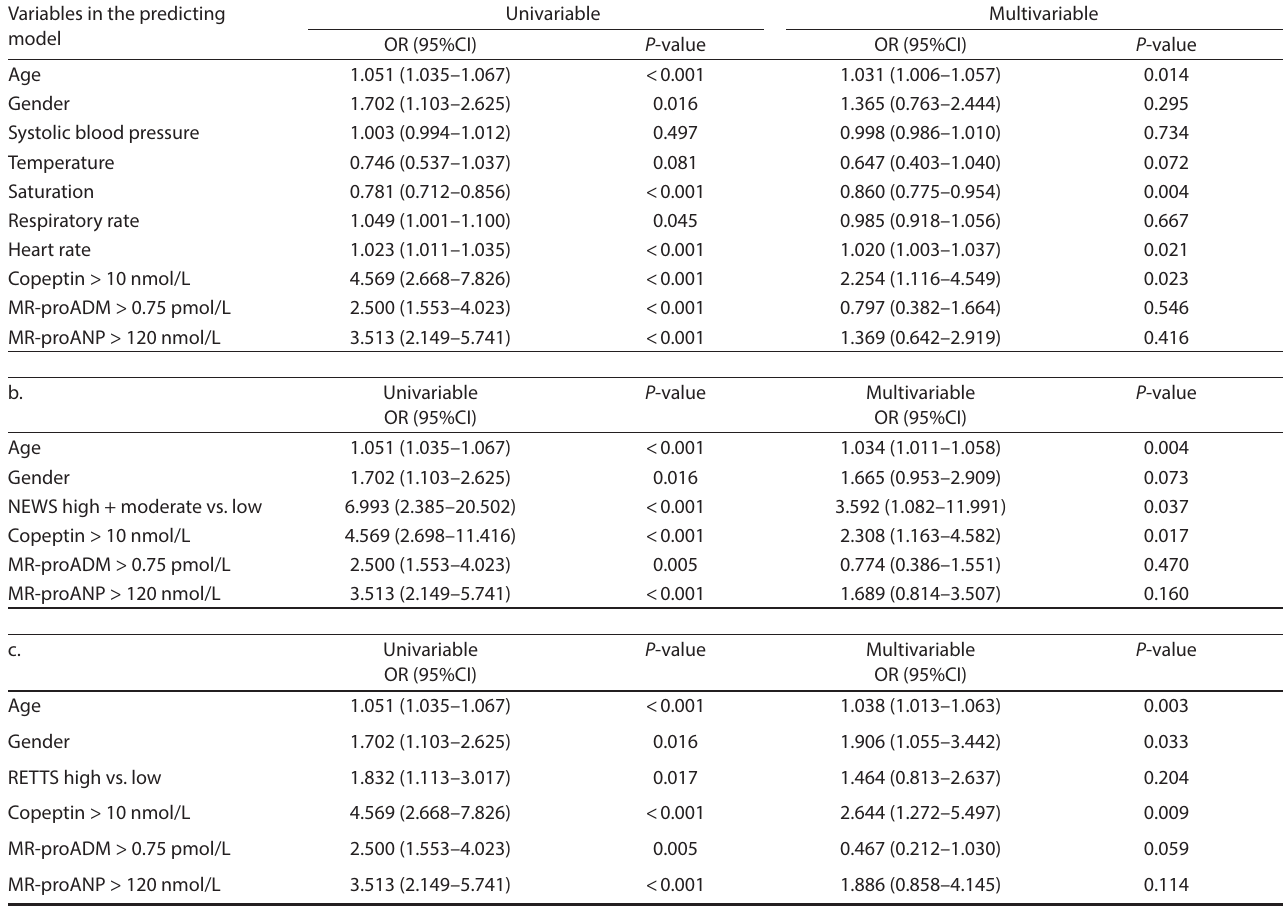
Table 4. Binary regression analyses for associations of age, gender, vital signs (a), NEWS (b), RETTS (c), and biomarkers with admission to a ward. Variables in the predicting